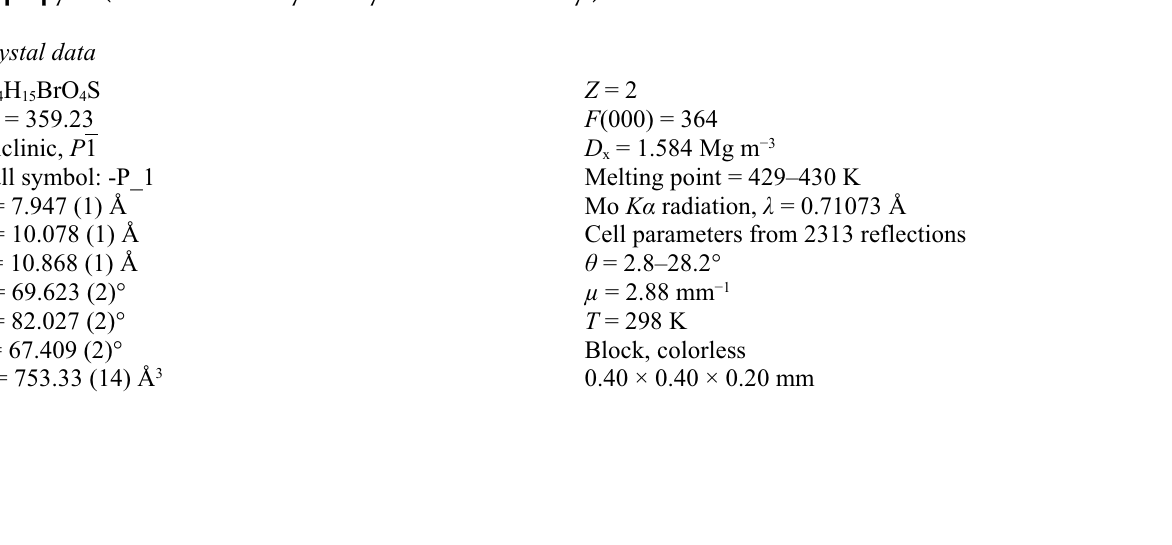
C—H··· π and C—H···O interactions (dotted lines) in the title compound. Cg denotes ring centroid. [Symmetry code: (i) x , y + 1, z ; (ii) - x , - y + 1, - z + 2; (iii) x , y - 1, z